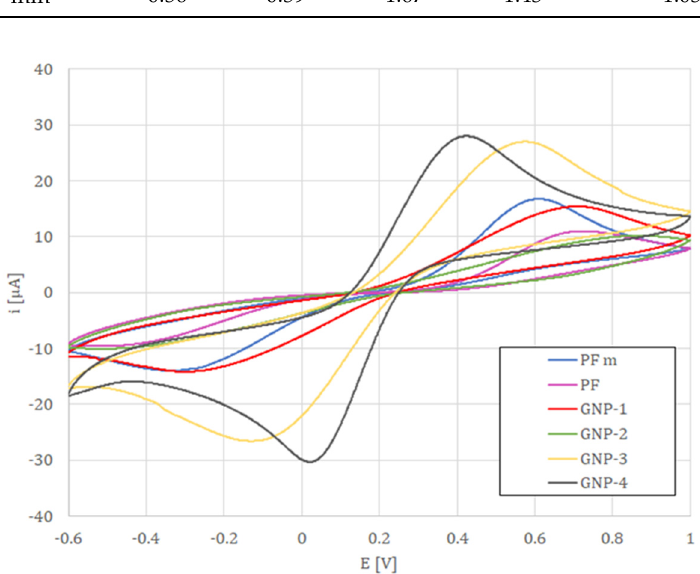
Figure 3. EIS measurements of the examined electrodes at a DC potential of 0.2 V, the amplitude of 0.005 V in the frequency range from 1 to 100 kHz vs. Ag/AgCl/1.0 molL − 1 KCL reference electrode, and a gold wire as the auxiliary electrode in 5 mM ferri/ferrocyanide. 3.1. General Rheological Properties of Printing Pastes Printing pastes are colloid suspensions, with the continuous medium of liquid polymer solution and the dispersed phase commonly called a filler in the field of printing technology. Shear-thinning behavior is a general quality required for the colloidal suspensions to be applicable in printing [26,37–41]. Due to the initial high viscosity, the paste remains stable on the screen before squeezing. Subsequently, due to the shear stress applied through the squeegee’s motion, the paste thins , i.e., its viscosity drops close to 0. In terms of the quality of the print, too low viscosity is undesirable. The material in such